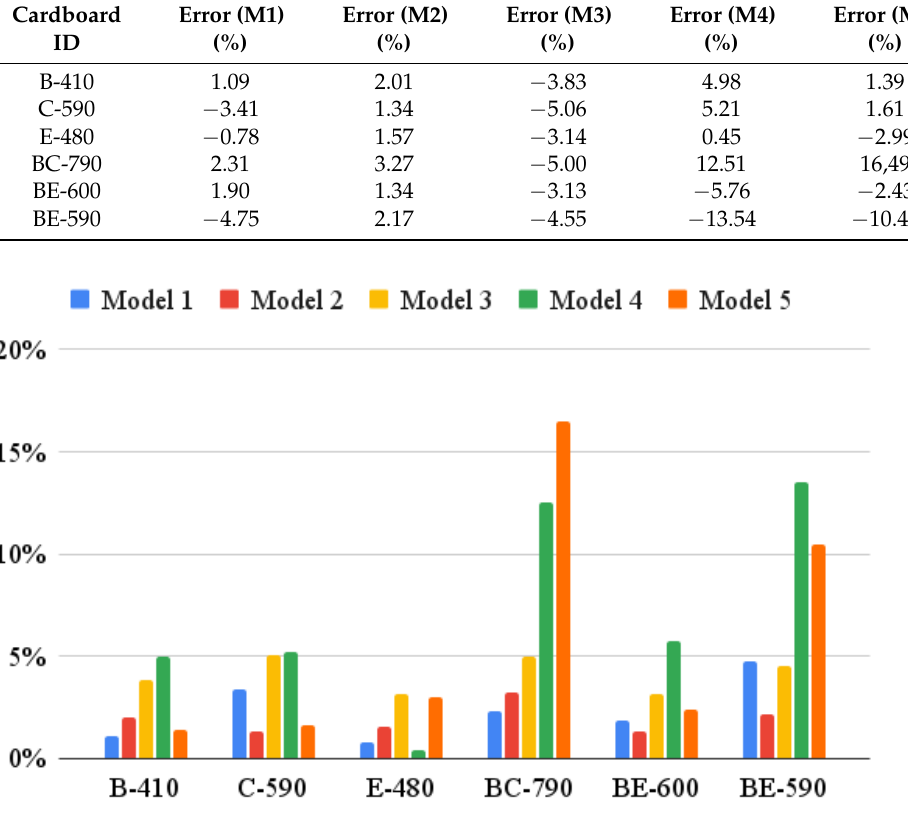
Figure 6. Absolute estimation error obtained using five different models.